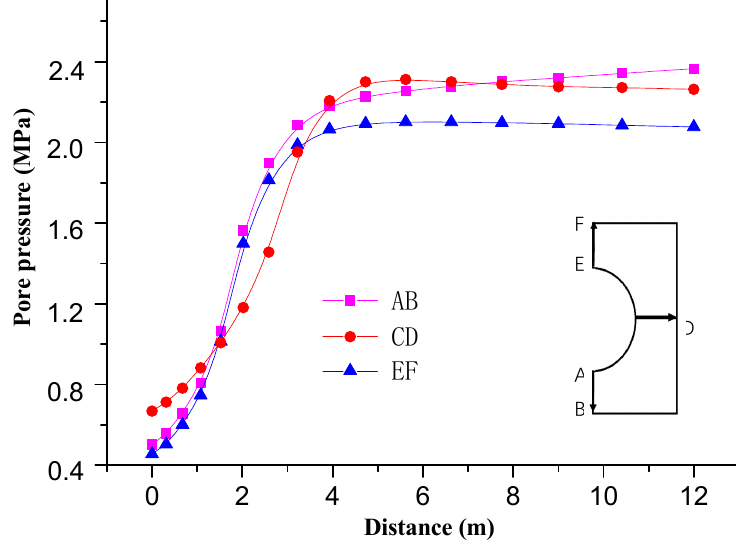
Figure 7. Variation curve of pore pressure at different positions of roadway.